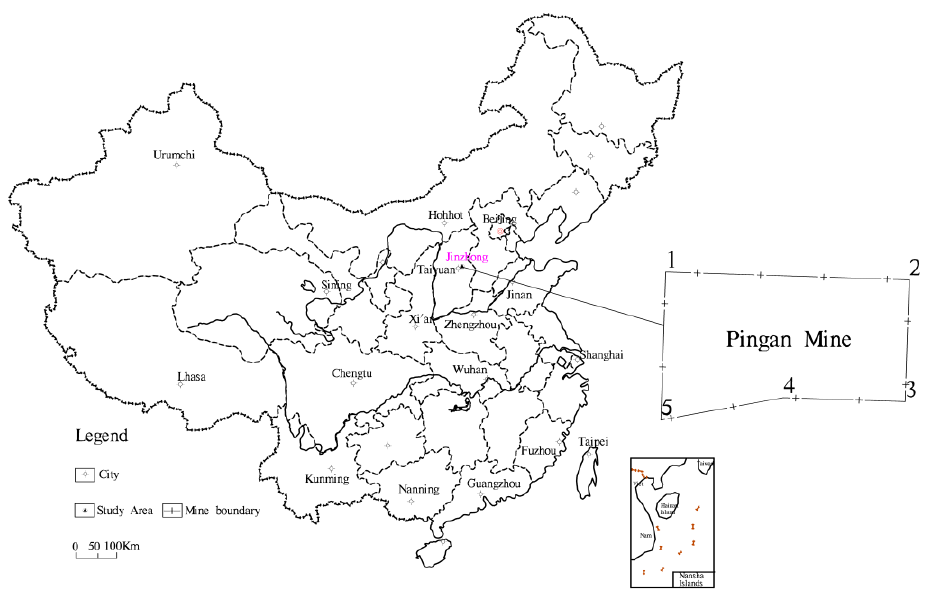
Figure 1. Location of Pingan underground coal mine.